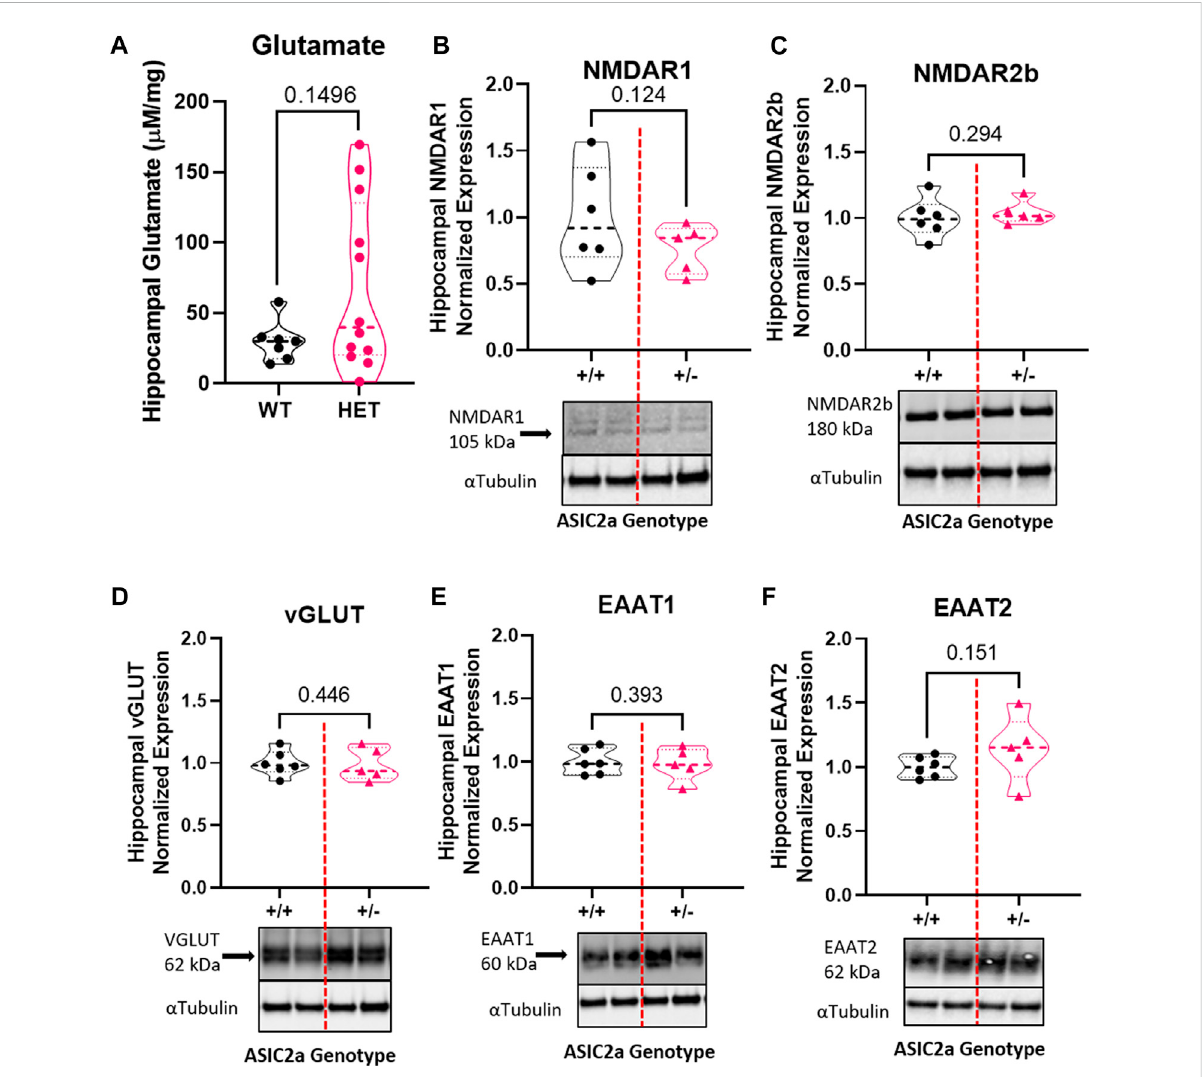
FIGURE 2 Changes in excitatory neurotransmitter-related proteins in hippocampal synaptosomes following seizures in pregnant mice with reduced ASIC2a. No difference in synaptosomal levels of (A) glutamate, (B) NMDAR1, (C) NMDAR2b, (D) EAAT1, (E) EAAT2, or (F) vGLUT following seizures in pregnant ASIC2a heterozygous mice. NMDAR - N-methyl-D-aspartate receptor, EAAT — excitatory amino acid transporter, vGLUT — vesicular glutamate transporter. N = fi ve to six mice per genotype. Individual data points are displayed. Thick dashed line is the median and the thin dashed lines are the quartiles Signi fi cance was calculated using Unpaired t